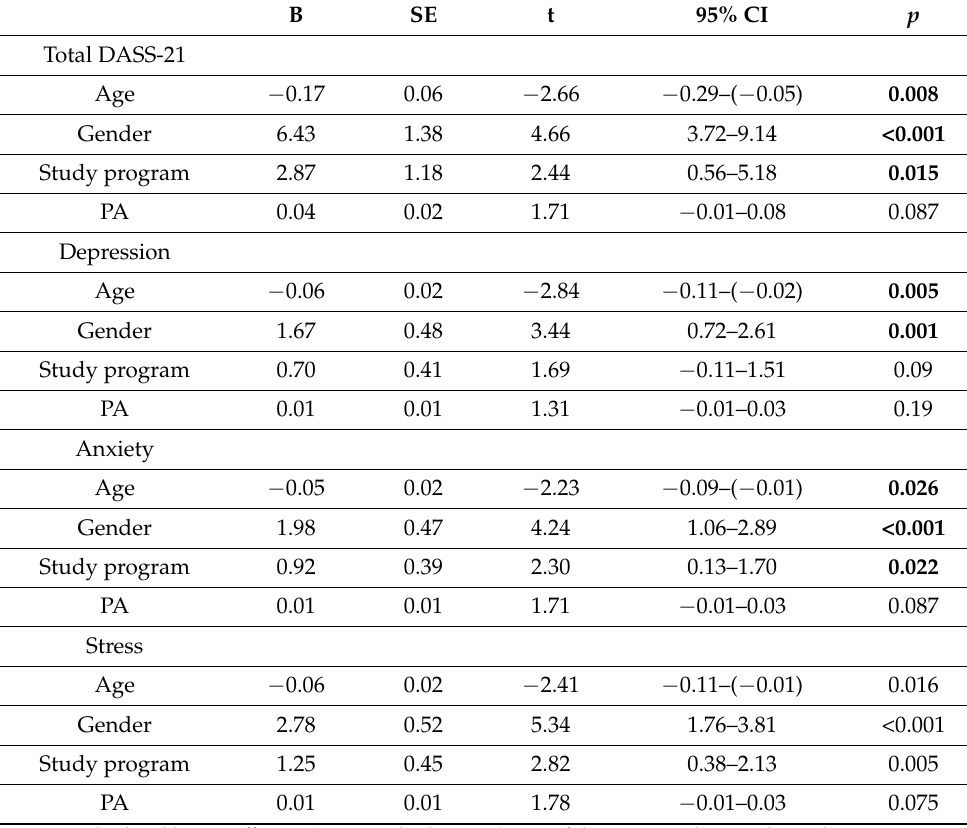
Table 4. Multivariate regression analyses on total DASS-21 scores and DASS-21 subscales (N = 823).